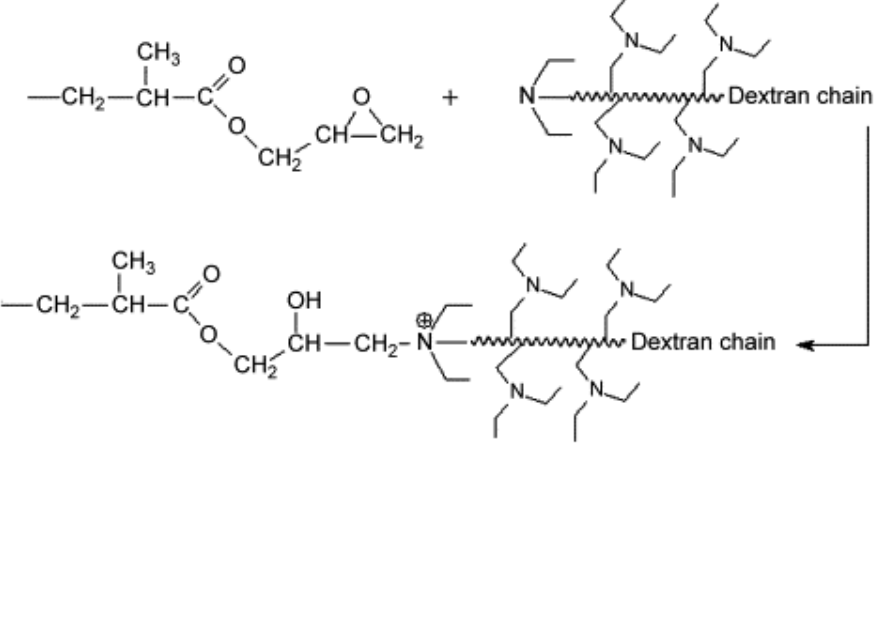
Figure 7. The illustration of reaction between DEAE-dextran and monolithic media [91]. Reprinted with permission from